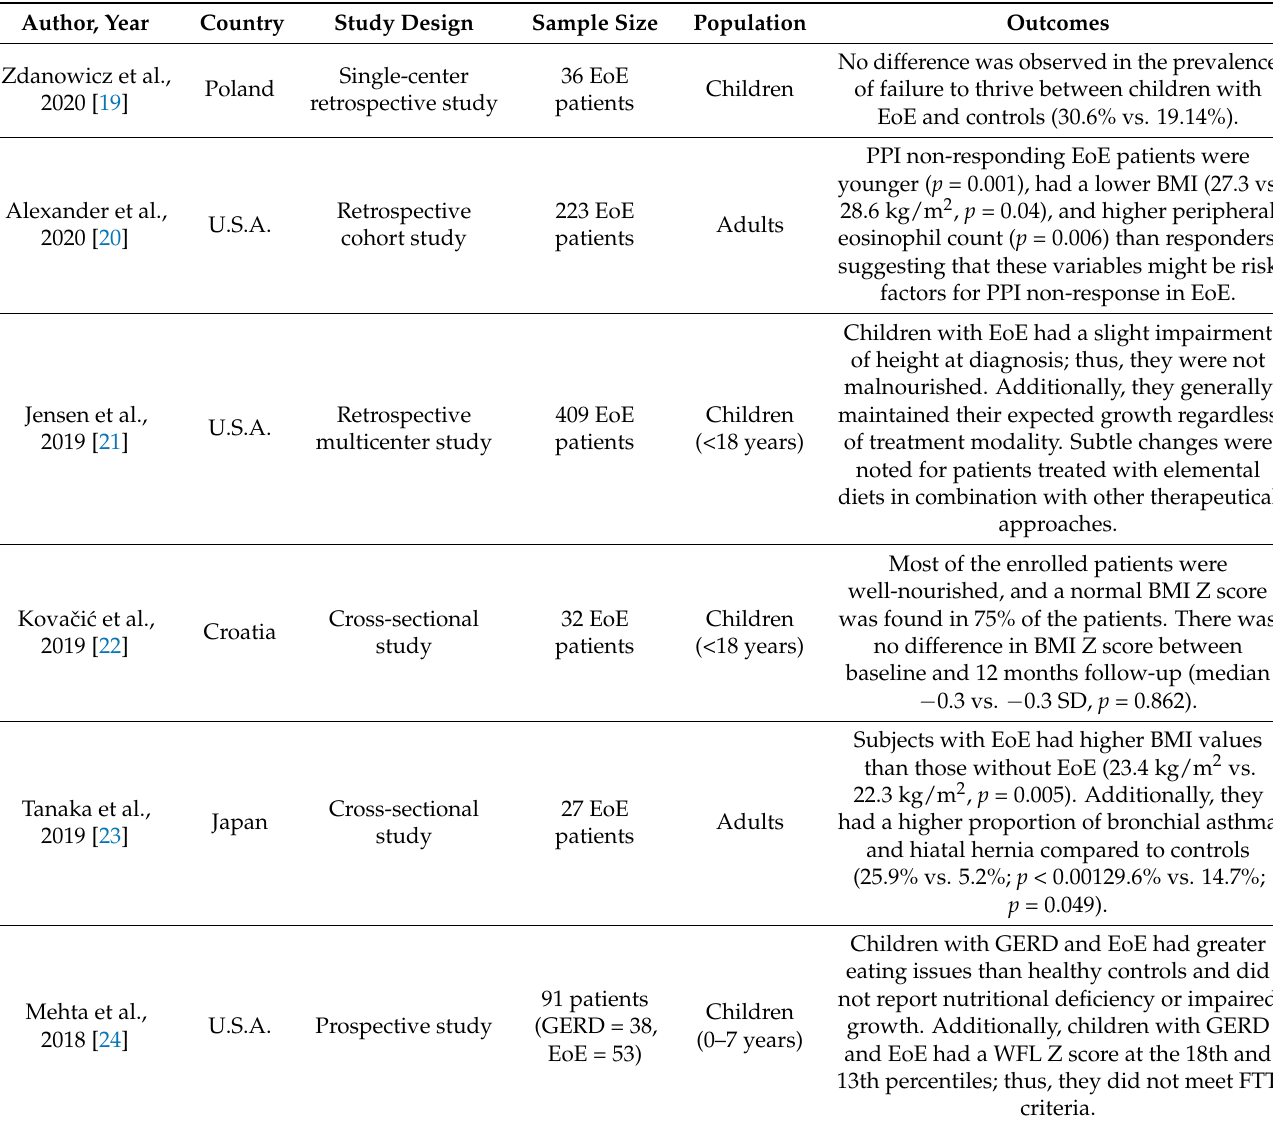
Table 2. Studies reporting a normal or high BMI of children and adult patients with EoE. No study has been published on